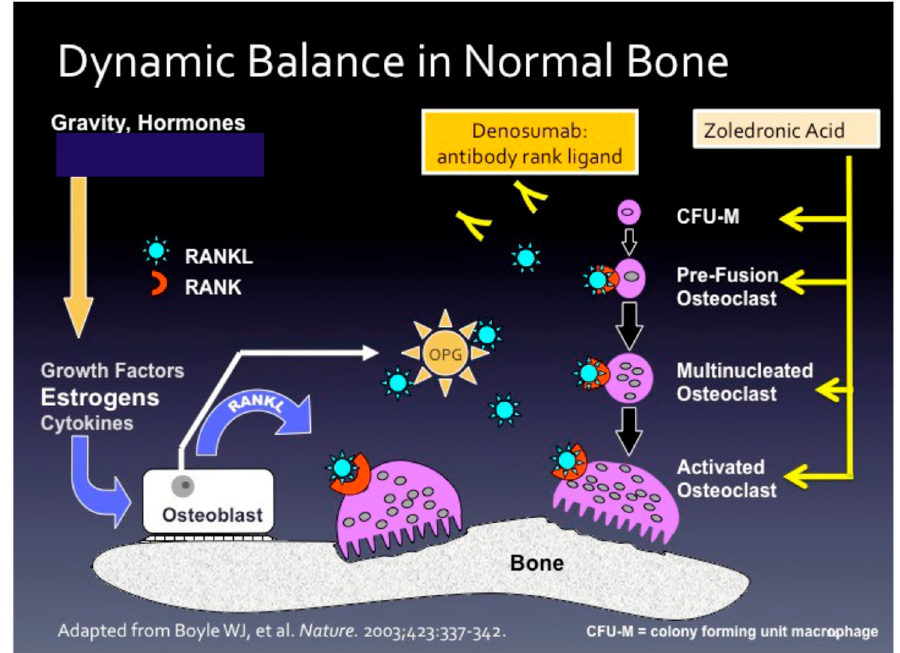
Figure 1. The dynamic balance of bone resorption and new bone formation. Two levels of regulation govern bone resorption and new bone formation. The Marco level is the effects of gravity, the mechanical stress and strains of activities of daily living, and systemic hormones including calcium-regulating hormones (parathyroid, calcitonin, and calcitriol), sex steroid hormones (estrogen and testosterone), and others (growth and insulin like-growth factor, thyroid hormones, and cortisol). At the Micro level is the dynamic interplay of osteoblasts, which cause new bone formation, and osteoclasts the resorb bone. The osteoblast is the master regulator cell secreting both receptor activator of nuclear factor- κ B ligand (RANKL) and osteoprotegerin (OPG) of the TNF receptor superfamily. RANKL binds to the Rank receptor and causes osteoclast precursor cells (derived from hematopoietic cells) to differentiate into mature osteoclasts and resorb bone. OPG acts as a decoy receptor for RANKL and causes inhibition of bone resorption and new bone formation. Zoledronic acid (ZA) is an osteoclast inhibitor. In contrast, denosumab (DEN) is a monoclonal antibody directed against RANKL. Both drugs inhibit osteoclastic functions from resorbing bone and for preventing or treating osteoporosis. ZA and DEN, as well as oral bisphosphonates, are discussed below in Section 7. Estrogens receptors (ER), both ER- α and ER- β , are located in osteoblasts, osteoclasts, and T-cells [5]. For example, when estrogen (17 β -estradiol) binds to ER- α , it induces Fas Ligand (FasL) transcription in osteoblasts. FasL is cleaved from the osteoblast surface by mixed metalloproteinase III, and soluble FasL induces osteoclast apoptosis [6]. RANKL increased whereas gene expression of OPG, TGF- β , IGF-1, and RUNX2 decreased when sh-RNA methods depleted ER- α [7]. When 17 β -